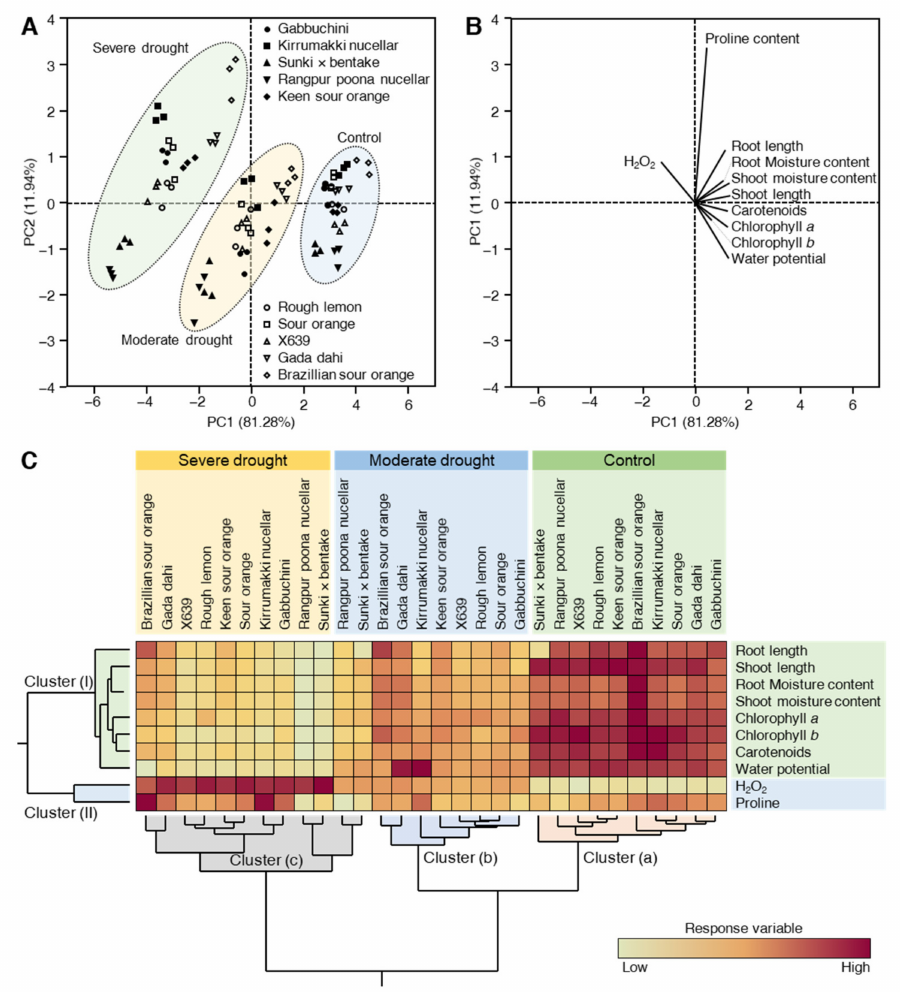
Figure 2. Principal component analysis (PCA) and two-way hierarchical cluster analysis (HCA) of individual morphological and physiological parameters were assessed in 10citrus rootstocks with distinct degrees of tolerance to drought stress under three water regimes. ( A ) PCA-associated scatterplots, ( B ) PCA-associated loading plots, and ( C ) two-way HCA. Variations in the dependent variables among studied treatments are visualized as a heat map. Rows correspond to dependent variables, whereas columns correspond to different treatments. Low numerical values are light- yellow-colored, while high numerical values are colored dark red (see the scale at the right bottom corner of the heat